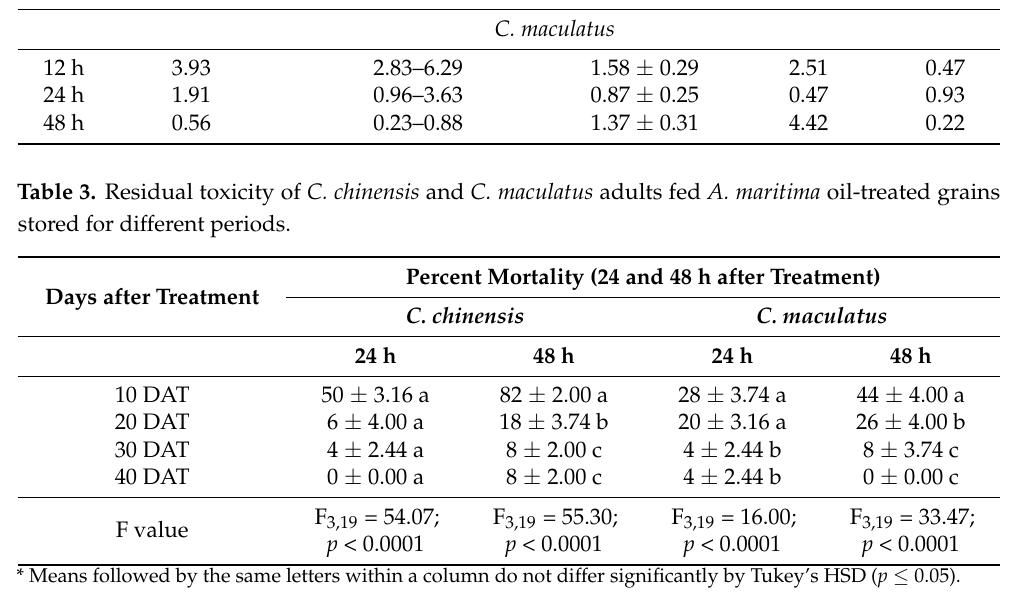
Table 4. LT 50 values of A. maritima oil-treated grains (higher concentration) against adults of C. chi- nensis and C. maculatus at different storage periods of 10, 20, 30, and 40